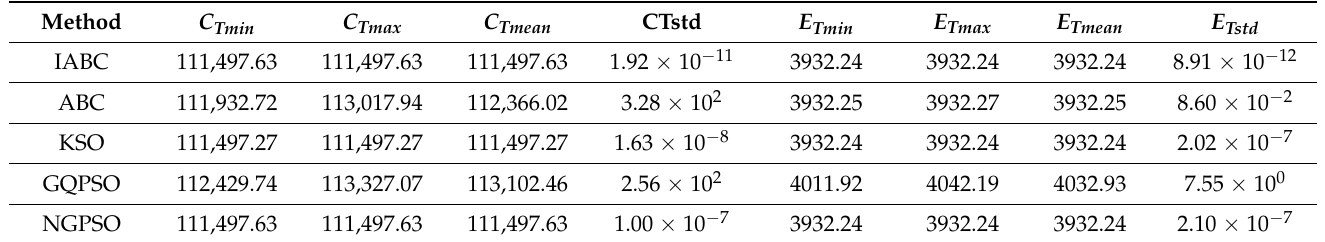
Table 2. Statistical results for case